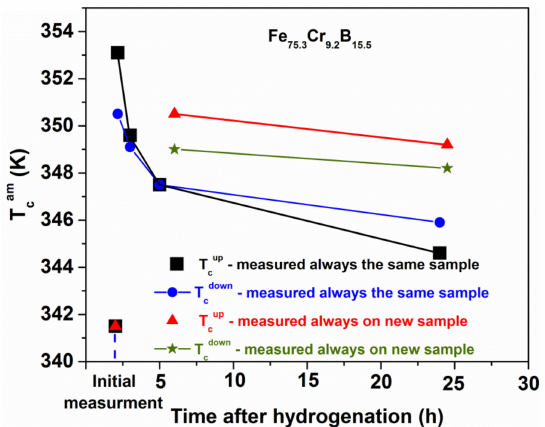
Figure 38. Monitoring of the H desorption in a Fe 75,3 Cr 9,2 B 15.5 glassy alloy during repeated Curie temperature T Cam measurements. Adopted from [132], with permission from Elsevier, 2006.